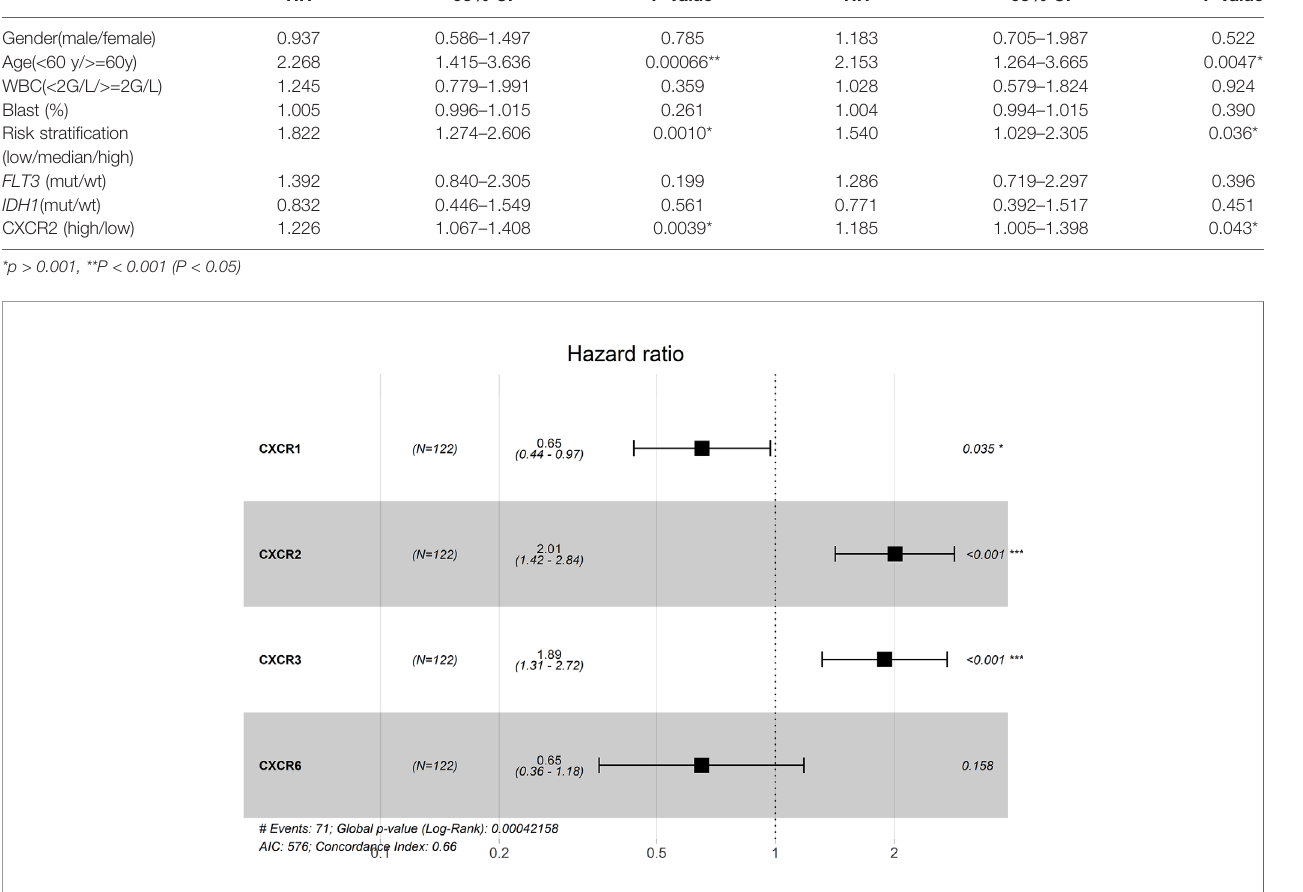
FIGURE 6 | The forest plot for the gene signature model and Concordance Index.